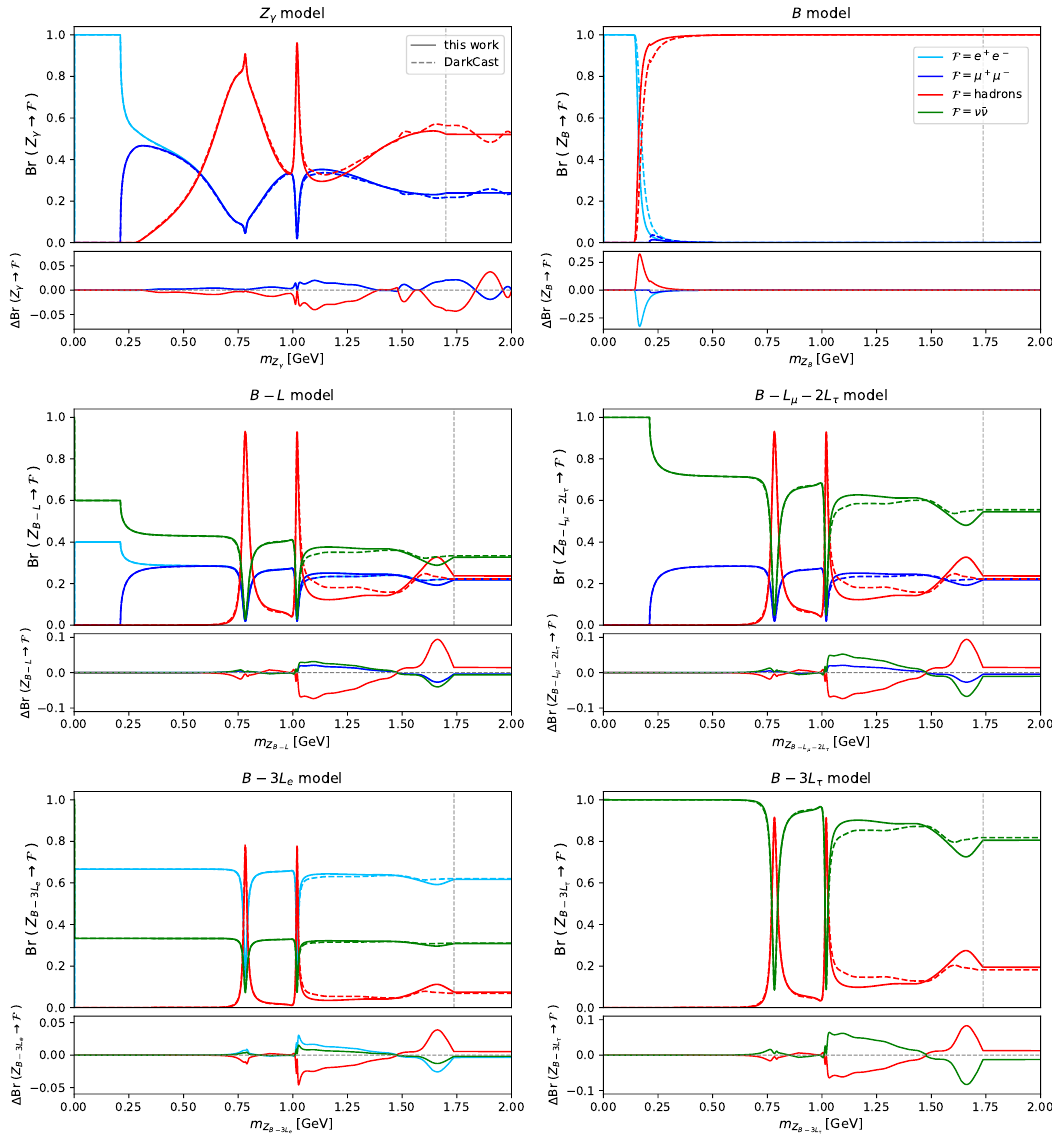
Figure 6 . Comparison of the leptonic and hadronic branching ratios (solid lines) with the ones from DarkCast (dashed lines) for some chosen models. The vertical dashed gray line indicates the transition from non-perturbative to perturbative calculations as described in the text. In the lower panel of each figure we show the deviation ∆Br , i.e. our branching ratio minus the DarkCast one.